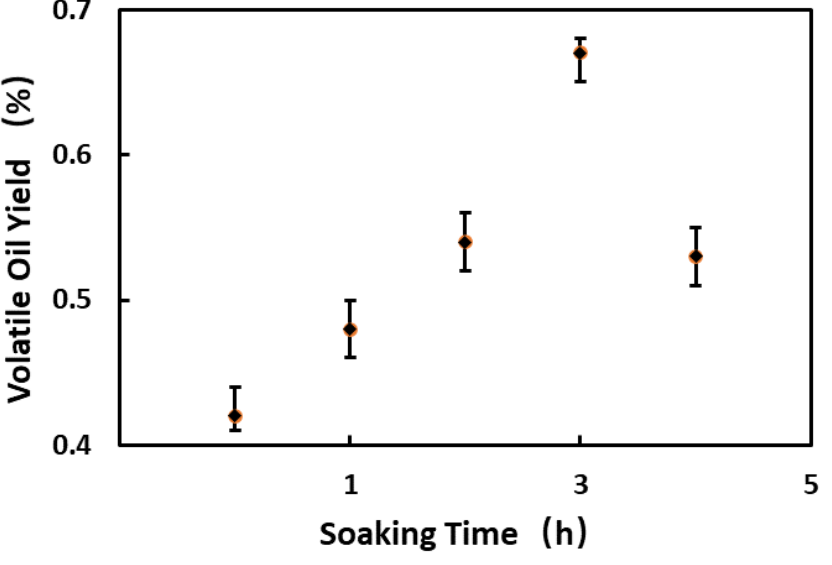
Figure 4. The effect of soaking time on the volatile oil yield ( n = 3).